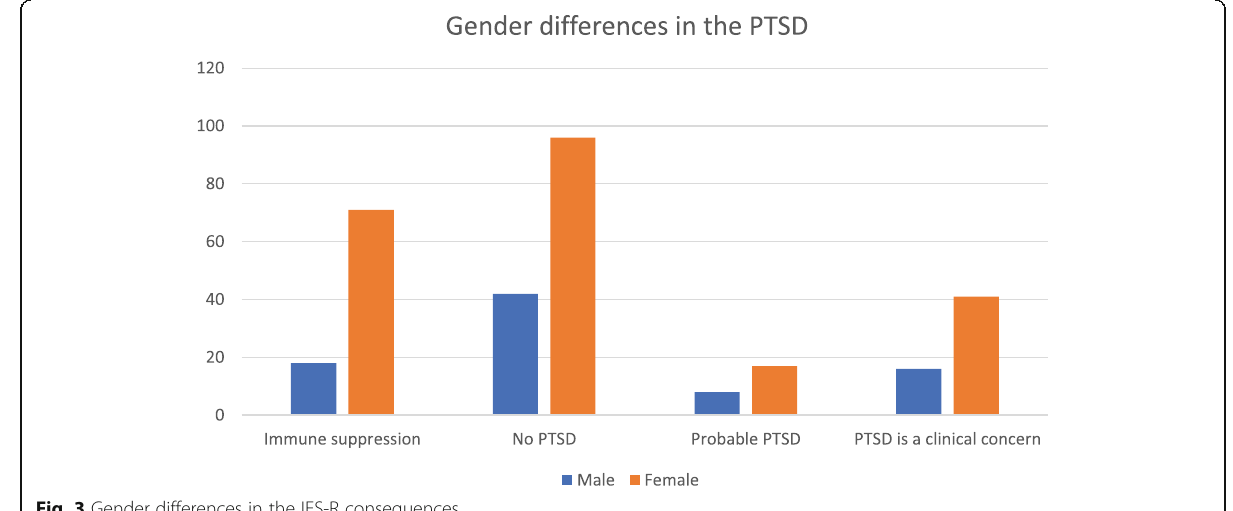
Fig. 3 Gender differences in the IES-R